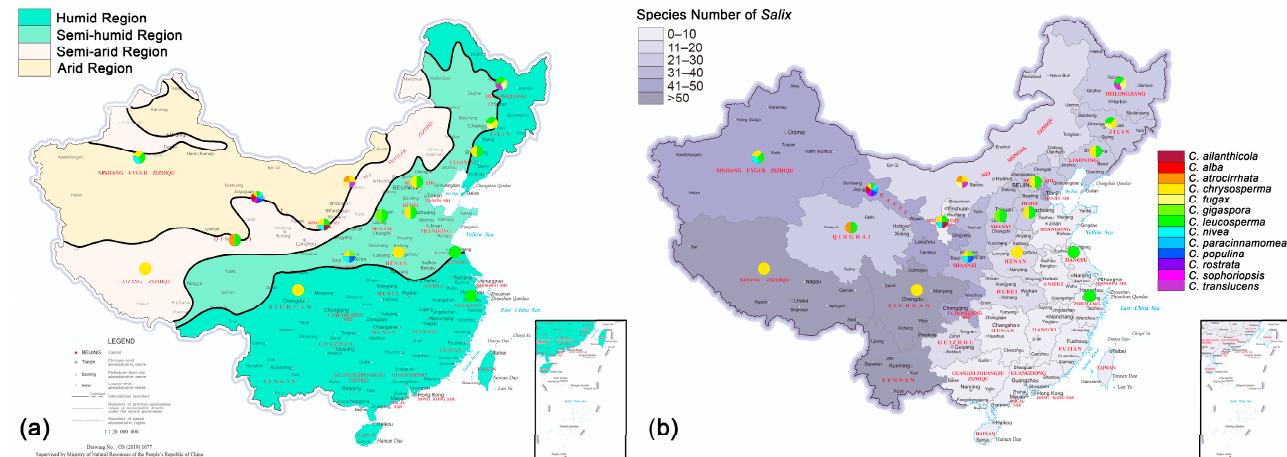
Figure 9. Geographical distribution of Cytospora species associated with willow canker disease in China: ( a ) drought conditions and Cytospora species richness of each province; ( b ) Salix species richness and Cytospora species richness of each province.